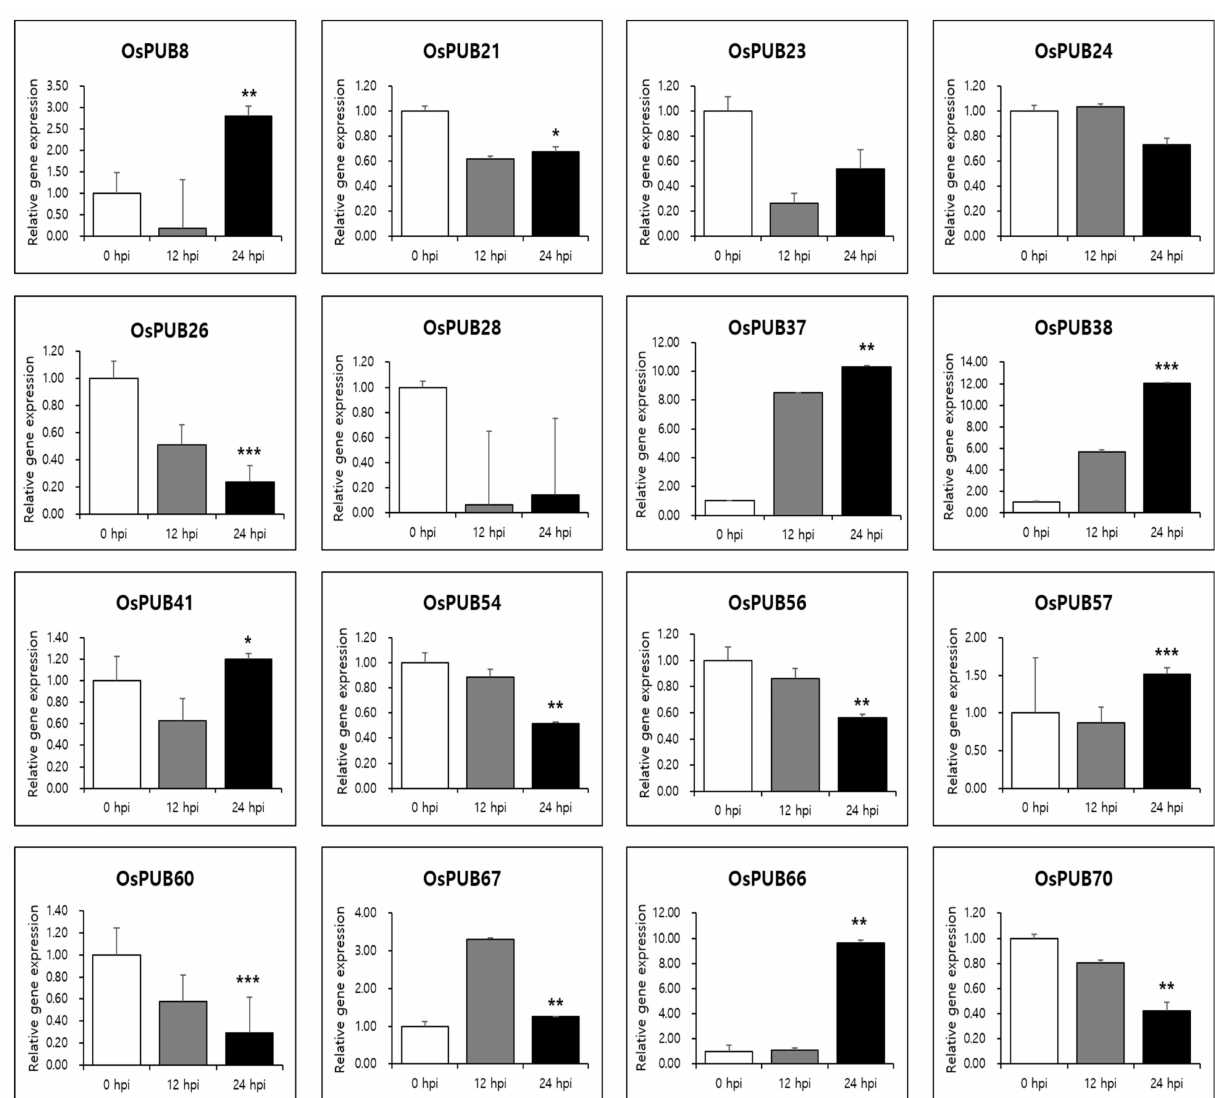
Figure 9. Expression patterns of OsPUB genes in response to infection of Magnaporthe oryzae analyzed by qRT-PCR. Relative gene expression was normalized against rice Actin gene. Values are presented as means ± standard error. Three independent biological repeats were performed. Bars represent standard deviations (SD) of three technical replicates. A significant difference is indicated by an asterisk according to t -test (* p < 0.05, ** p < 0.01, and *** p <